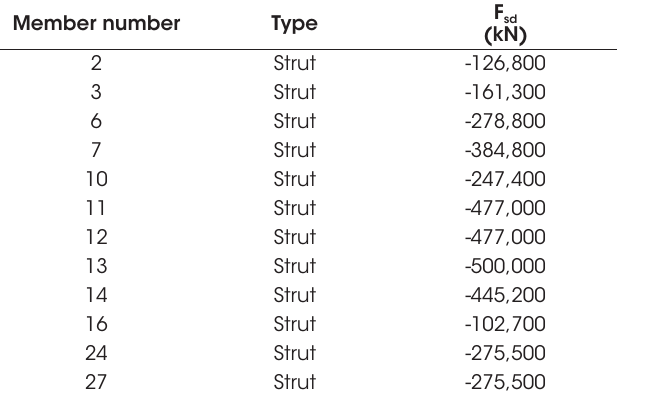
Design axial forces in the struts of the Example 3 Member number